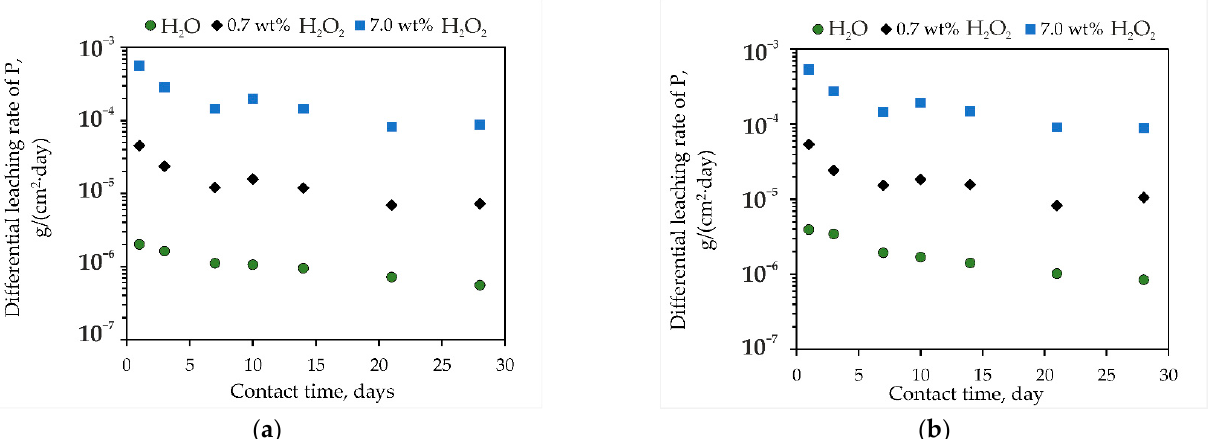
Figure 2. Kinetic curves of the leaching rate of P from ( a ) initial samples of NAFP glass and ( b ) samples after heat treatment at 450 °C.